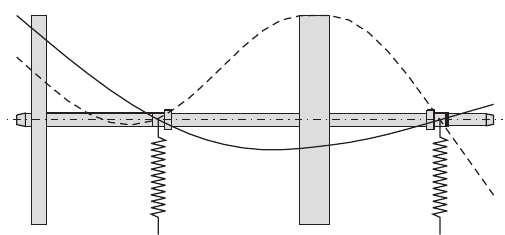
Figure 3: The first and second eigenforms of the rotor test